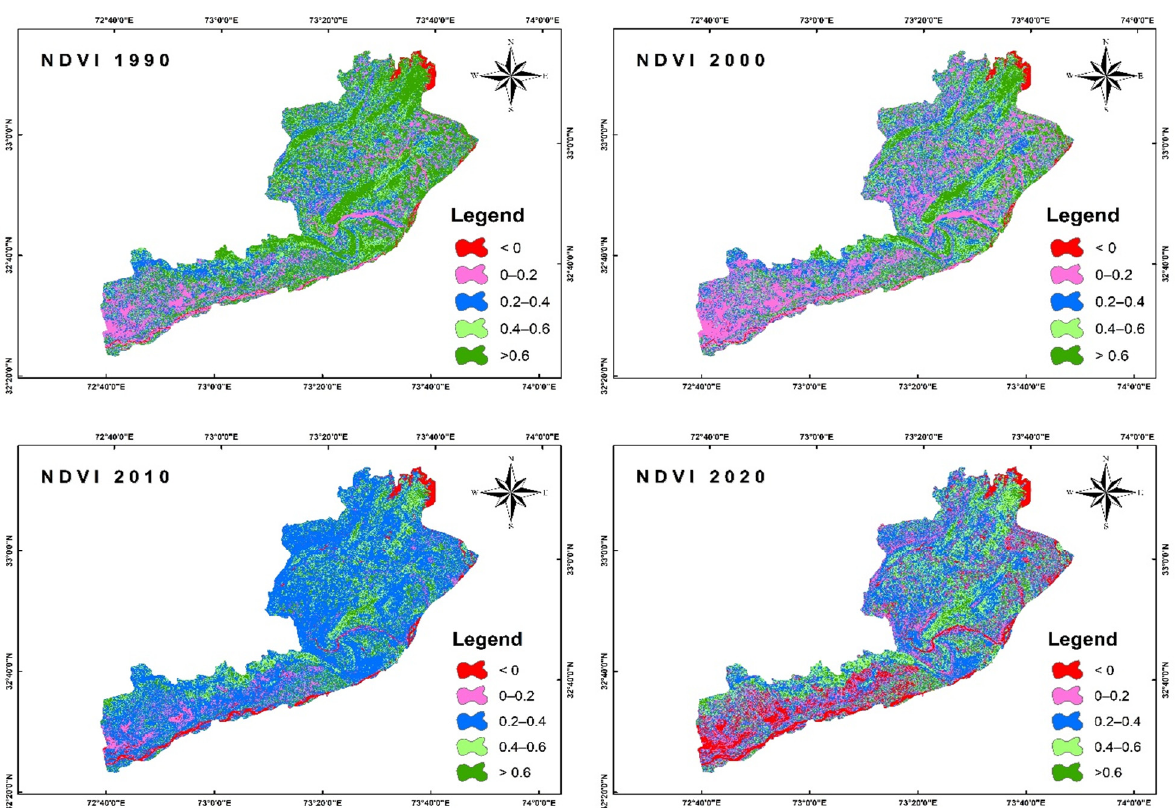
Figure 7. Normalized difference vegetation index maps of Jhelum.